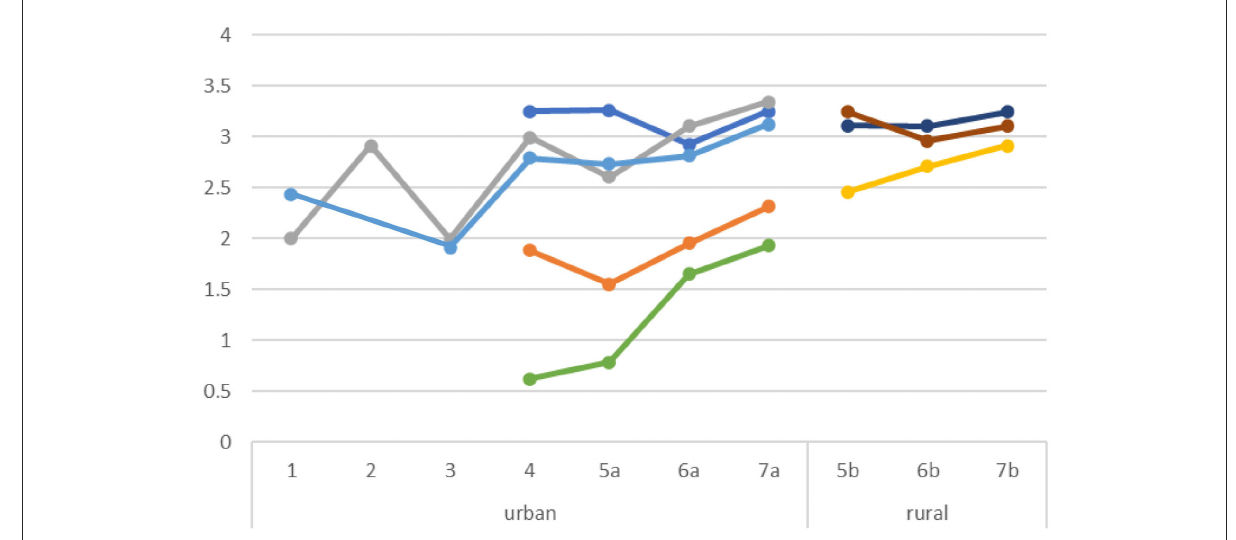
FIGURE4 Journey Score per clinic. Each color represents a different clinic. Scores on a scale of